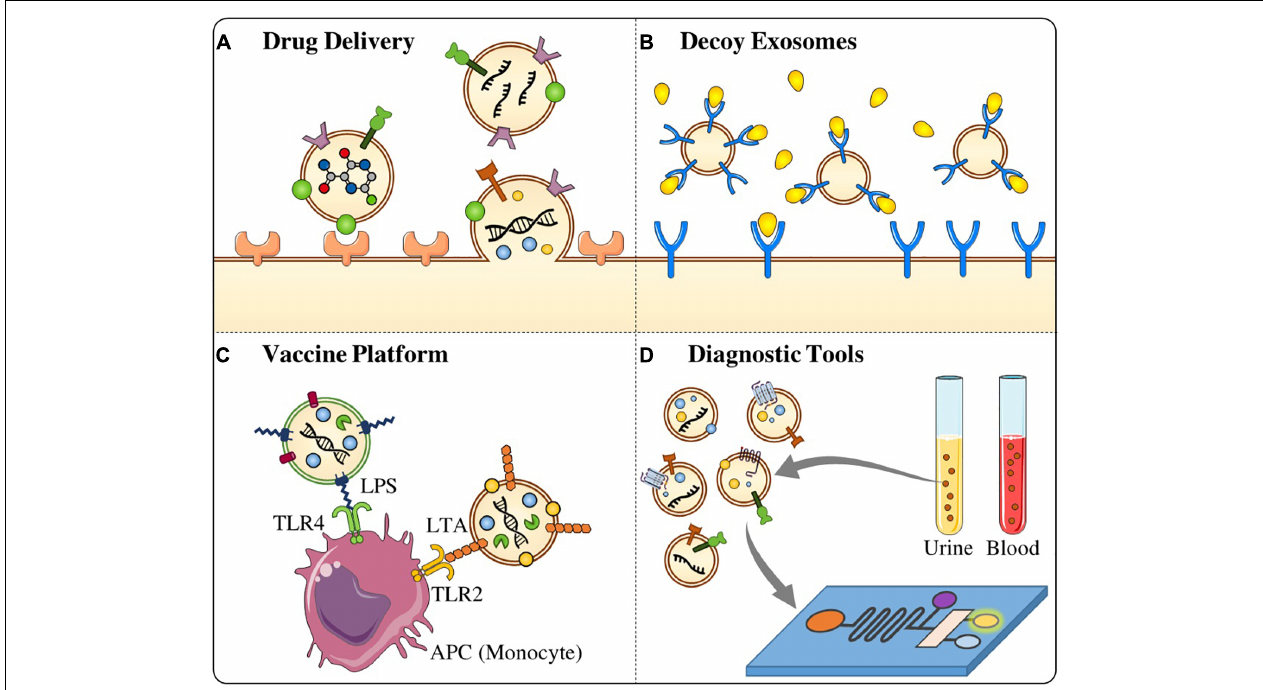
FIGURE 2 | Potential application of stem cell-derived EVs on pathogenic microbes. (A) Stem cell-derived EVs can be used as a targeted drug delivery tool against infectious microbes. (B) Decoy exosomes are a biological trap which can absorb and antagonize detrimental factors such as bacterial toxins and inflammatory mediators. (C) EVs derived from MSCs are also can be used as vaccine platform to activate the immune response and react against the infectious diseases. (D) MSCs-derived EVs are good candidate for the development of diagnostic tools as they are involved in several biological processes and isolated from different